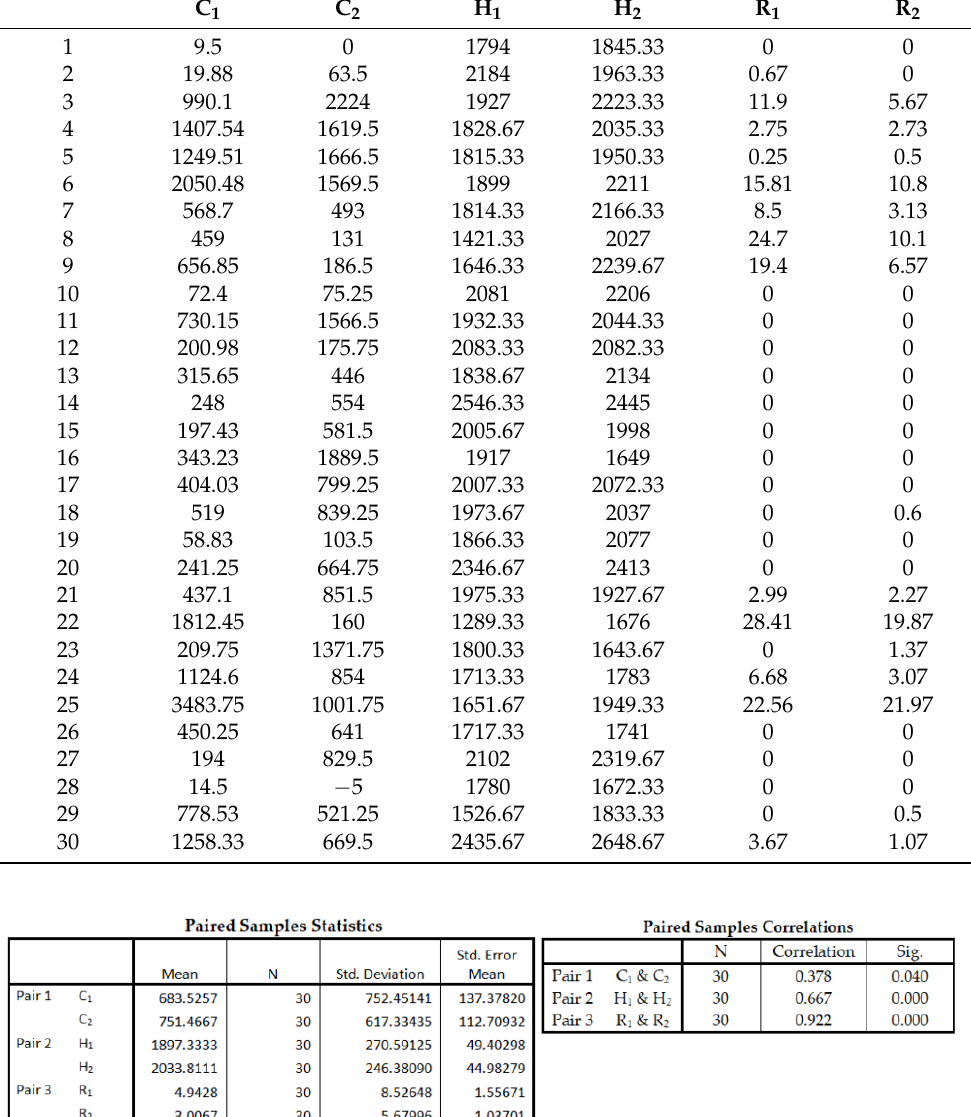
Table 9. Data in two-pair sample t test.